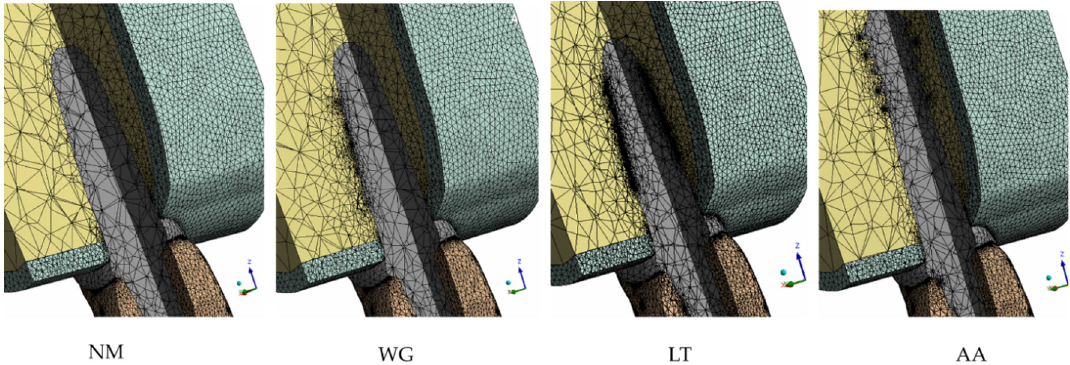
Figure 5. Sectional view of generated meshes in enodosteal region of each experimental group.